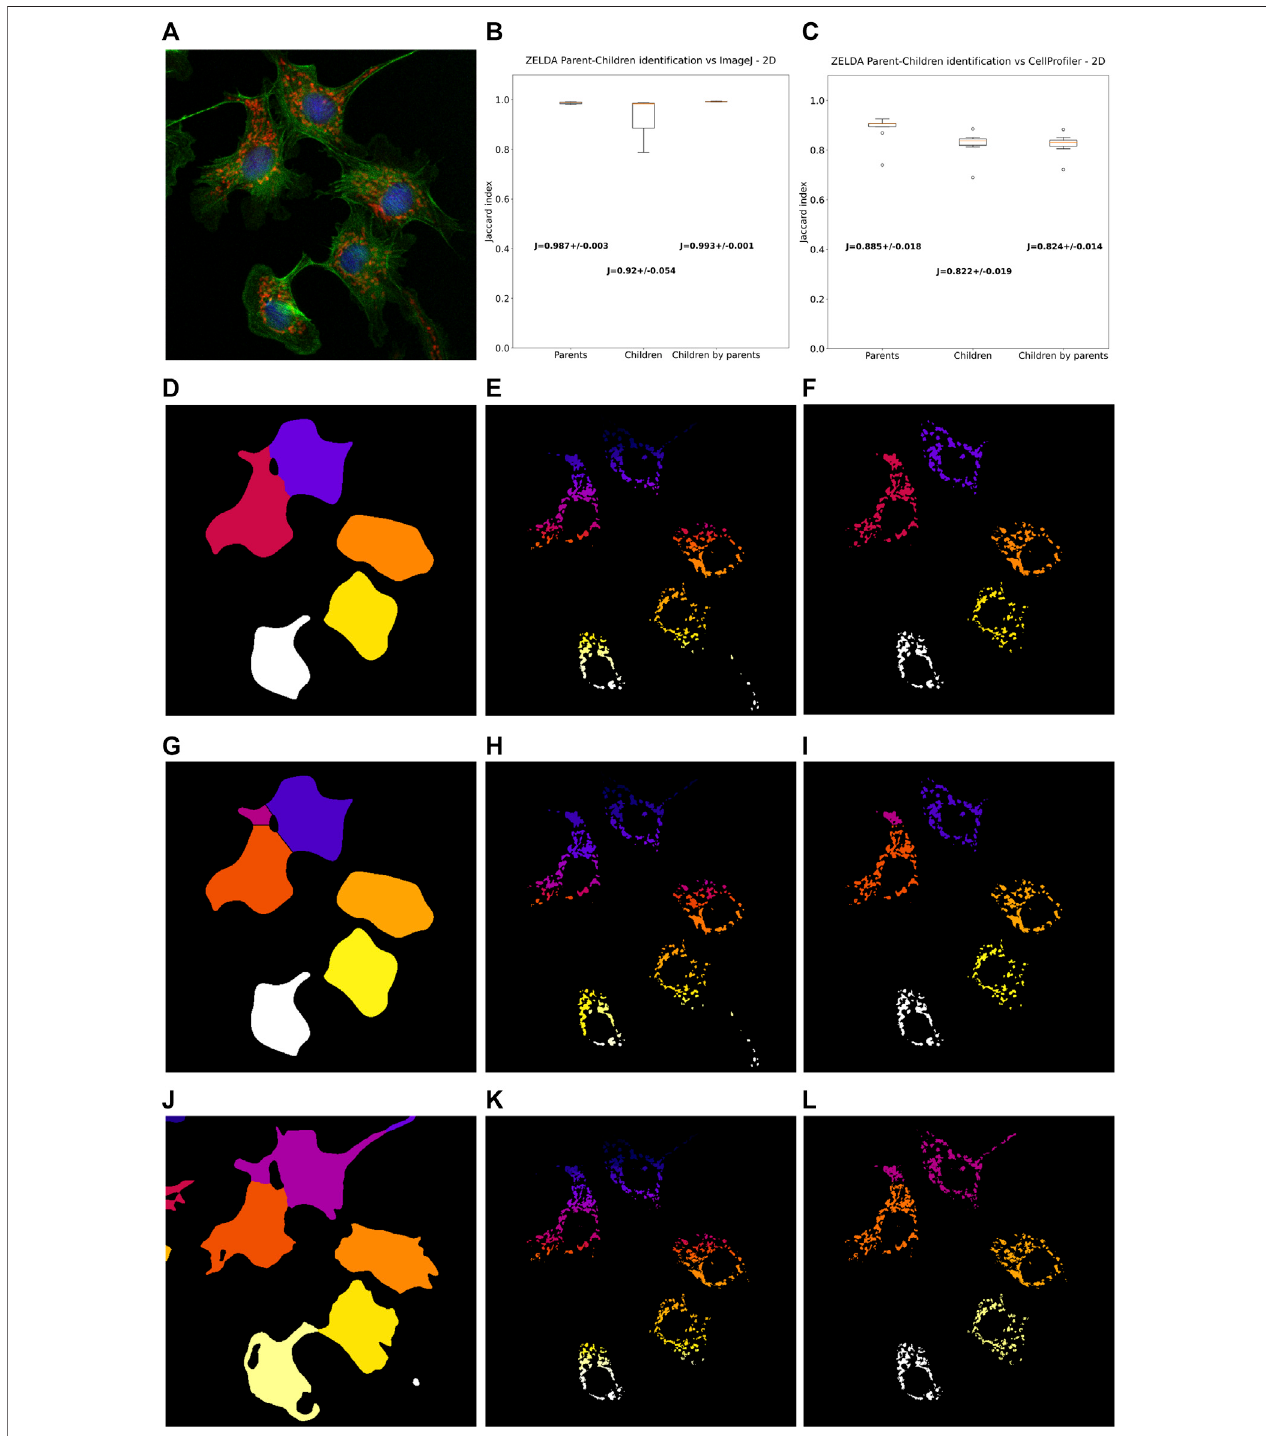
FIGURE 4 | ZELDA 2D segmentation and “ parent-child ” relation benchmarked with ImageJ and CellPro fi ler . (A) 2D images of BPAE cells stained with DAPI (blue, cellnuclei),AlexaFluor488(green,cytoplasms),andMitoTrackerRed(red,mitochondria). (B) LabellingcomparisonbetweenZELDAand ImageJ showinganaccordance abovethe98%ofthepixelsfor “ parent ” objects(cellcytoplasms),92%for “ child ” objects(mitochondria),and99%fortheparent-childrelation. (C) Comparisonbetween ZELDA and CellPro fi ler showing a minor accordance still above the 88% of the pixels for “ parents ” , 82% for “ children ” , and 82% for the “ parent-child ” relation. ZELDA labelling of (D) cell cytoplasms, (E) mitochondria, and (F) masked mitochondria (parent-child relation). ImageJ labelling of (G) cell cytoplasms, (H) mitochondria, and (I) masked mitochondria (parent-child relation). CellPro fi ler labelling of (J) Cell cytoplasms, (K) mitochondria, and (L) masked mitochondria (parent-child relation).